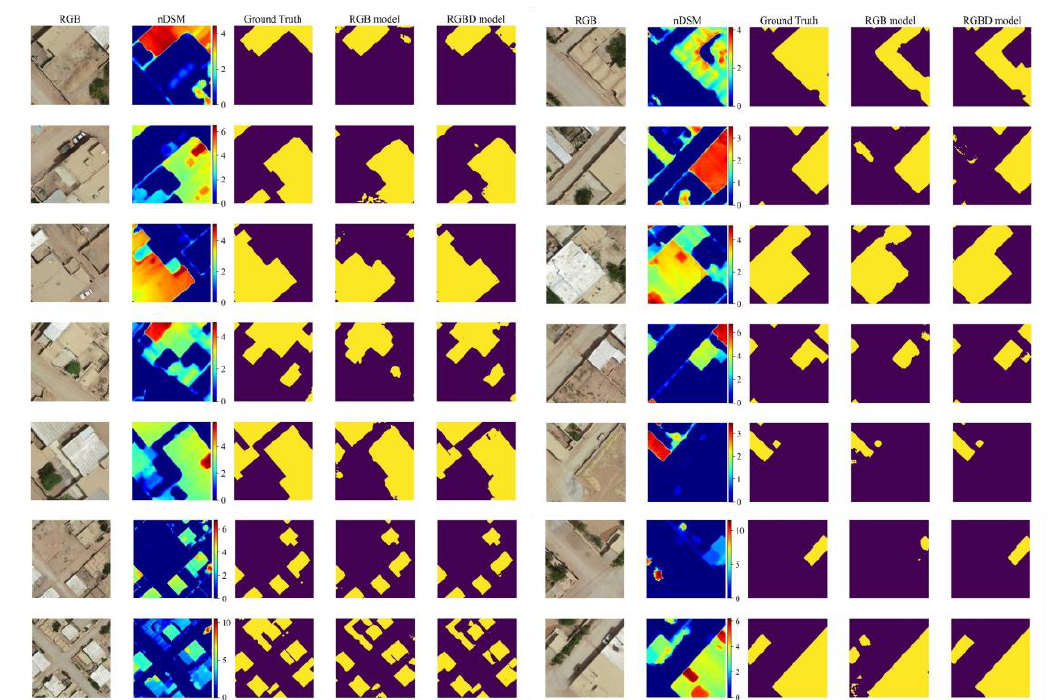
Figure 5 . The results of RGB and RGBD models on the test